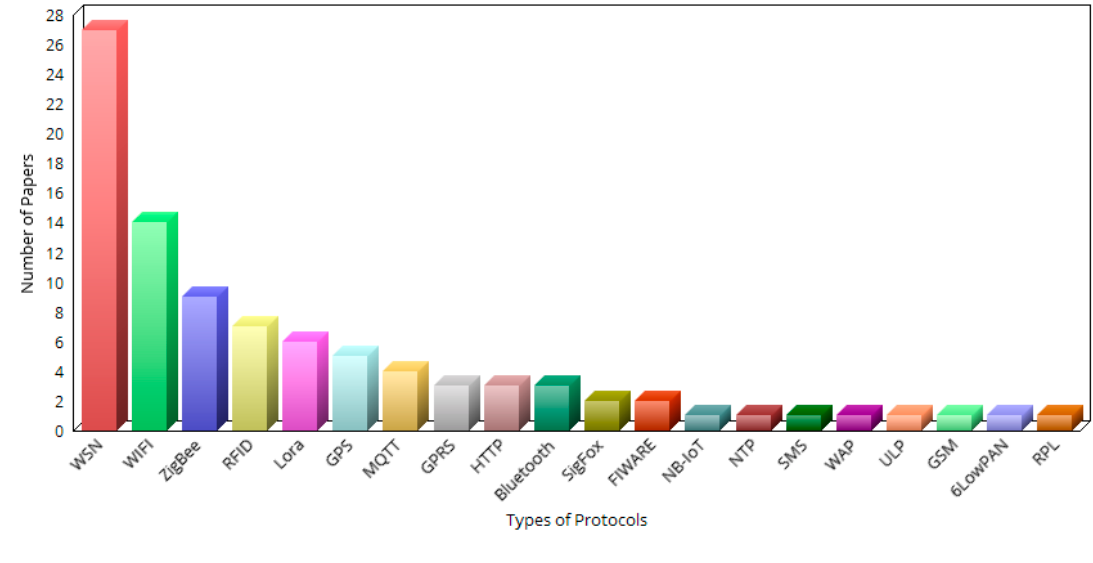
Figure 7. Communication protocols.